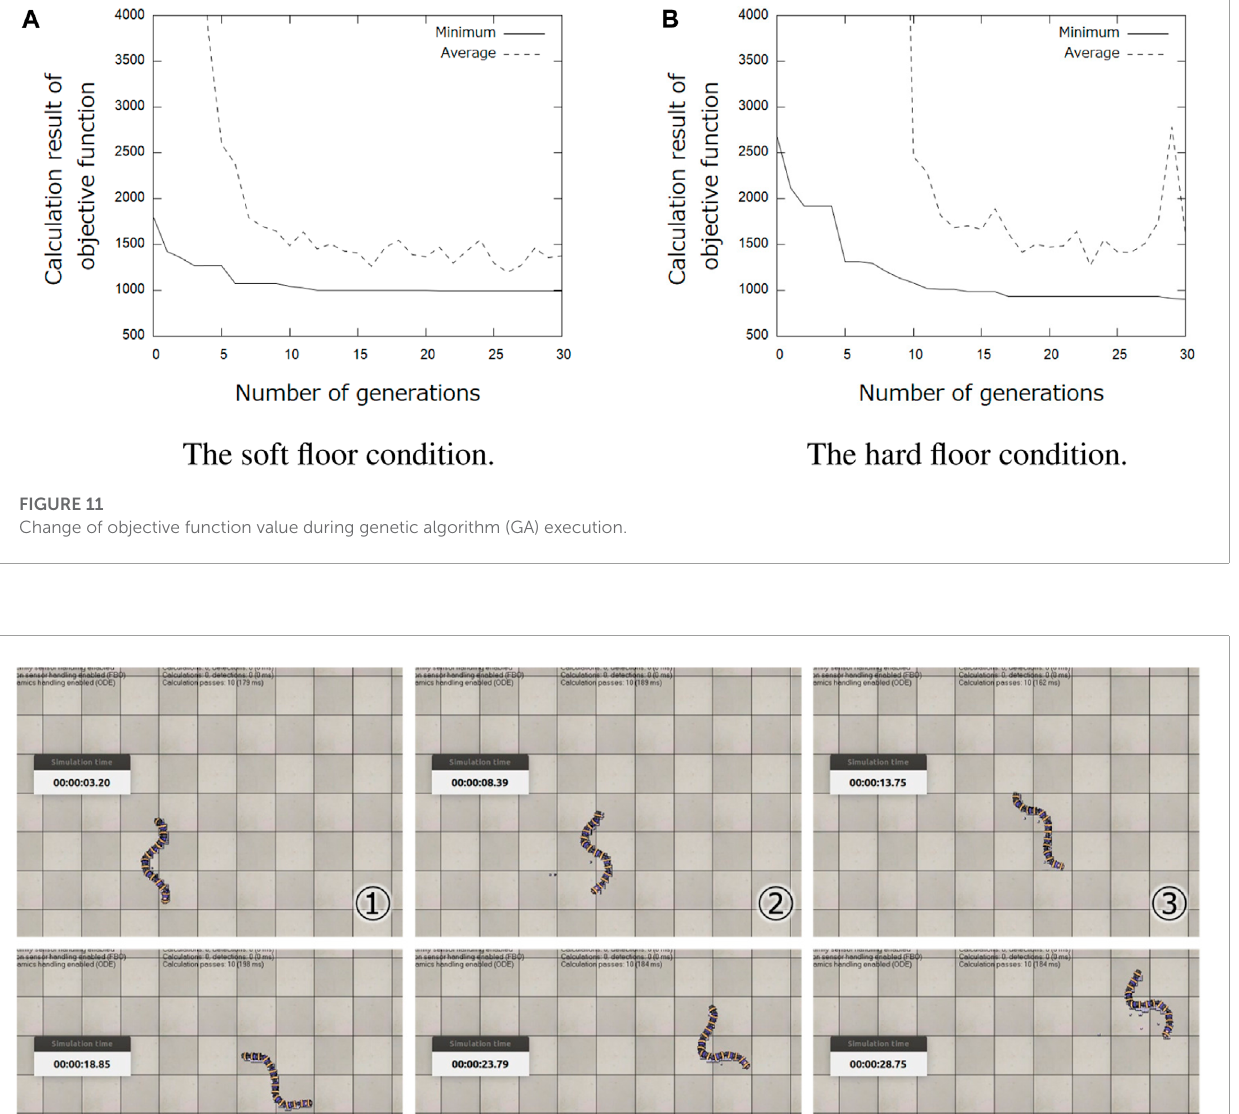
FIGURE 12 Propulsion behavior on the soft floor with parameters obtained under the soft floor condition.